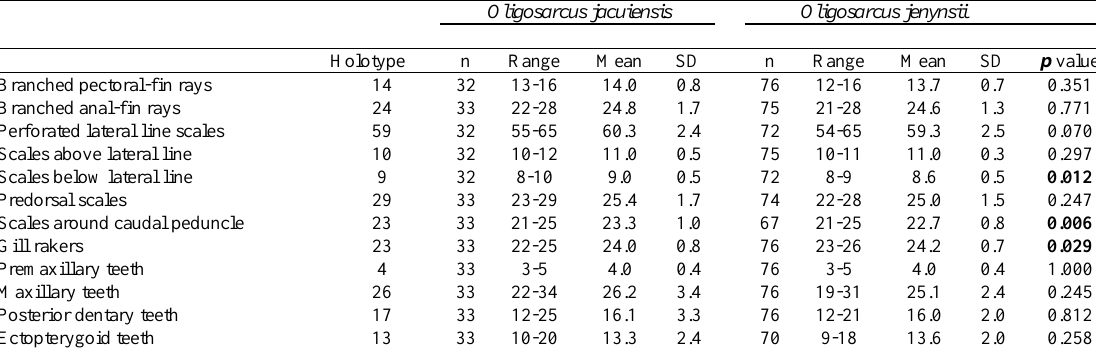
Table 2. Meristic data of Oligosarcus jacuiensis , new species (MCP 28980, holotype; MCP 18876, 26979, 37930, 44405; and MZUSP 104604, paratypes). Data of O . jenynsii (see comparative material examined) introduced for comparison.